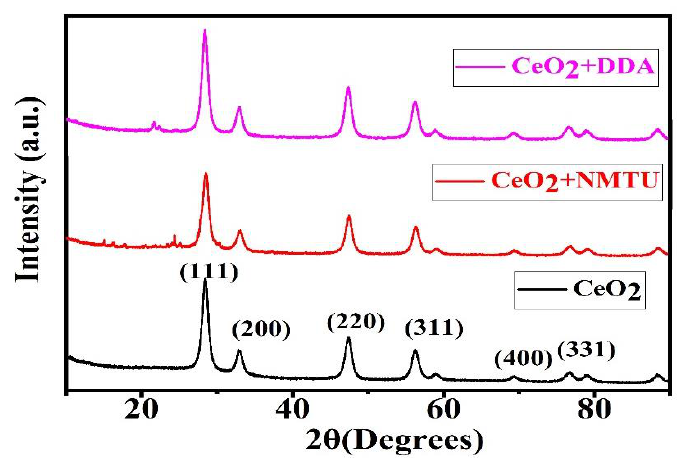
ff raction (XRD) di ff raction spectra of unmodified and modified CeO Figure 3. X-ray diffraction (XRD) diffraction spectra of unmodified and modified CeO 2. Figure 3. X-ray di